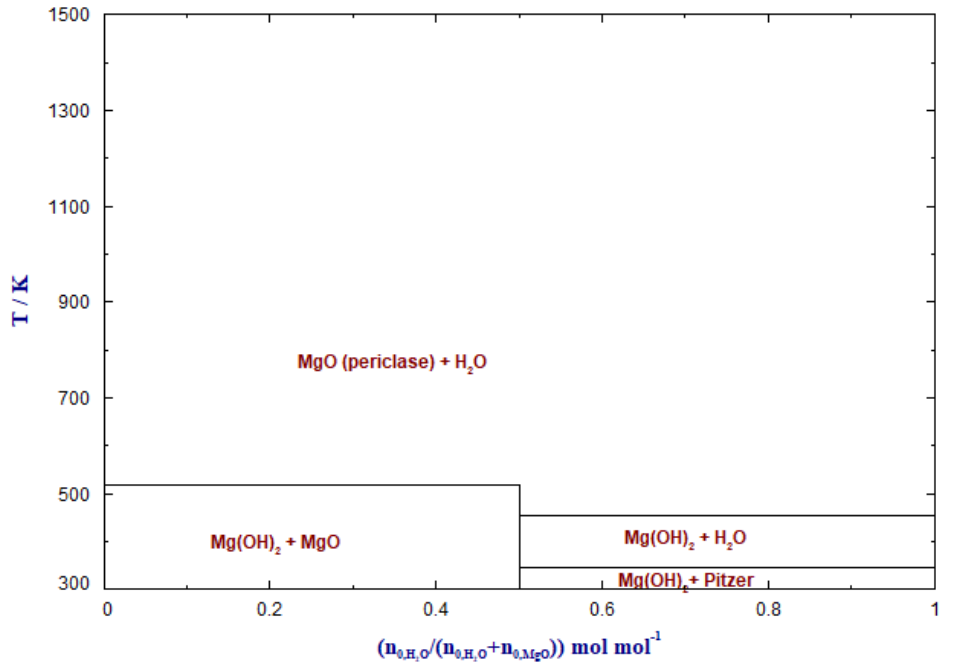
Figure 5. Equilibrium solid phase diagram of the system MgO–H 2 O: solid phase fields were predicted as a function of the temperature and the feed hydrogen mole fraction; gaseous products are not shown; data calculated with FactSage 8.0™ (Thermfact and GTT-Technologies). The solid phases at equilib- rium were predicted as a function of the temperature and the feed H 2 O ( n 0,H 𝑛 )), where n 0 denotes the number of moles of the feed component. 0,MgO